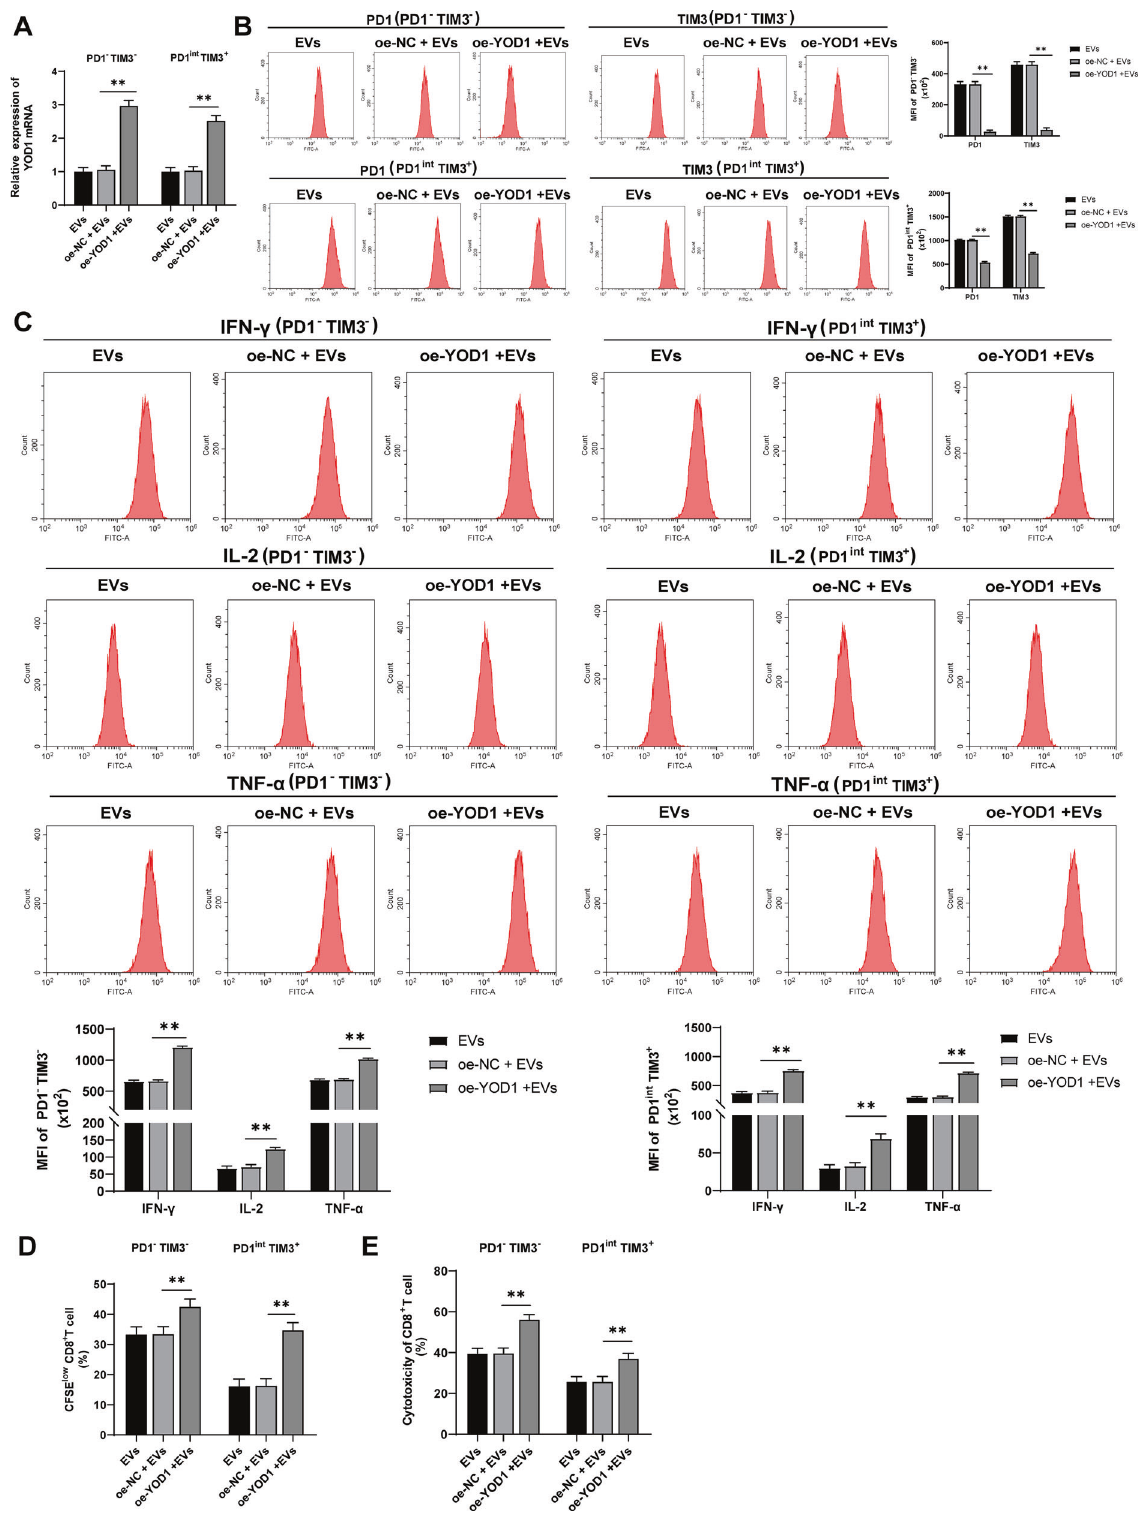
Fig. 6 Overexpression of YOD1 reversed the effect of EVs on CD8 + T cell exhaustion. pcDNA-YOD1-transfected CD8 + T cells were treated with EVs. A YOD1 mRNA expression was detected using RT-qPCR. B The expressions of PD1 and TIM3 were detected using fl ow cytometry. C The expressions of IFN- γ , IL-2, and TNF- α were detected using fl ow cytometry. D The proliferation ability of PD1 - TIM3 - and PD1 int TIM3 + cells was measured using fl ow cytometry. E The ability of PD1 - TIM3 - and PD1 int TIM3 + cells to kill Hep1-6 cells was measured using fl ow cytometry. The cell experiment was repeated 3 times. Data are presented as mean ± standard deviation and analyzed using one-way ANOVA, followed by Tukey ’ s multiple comparison test, ** p < 0.01.